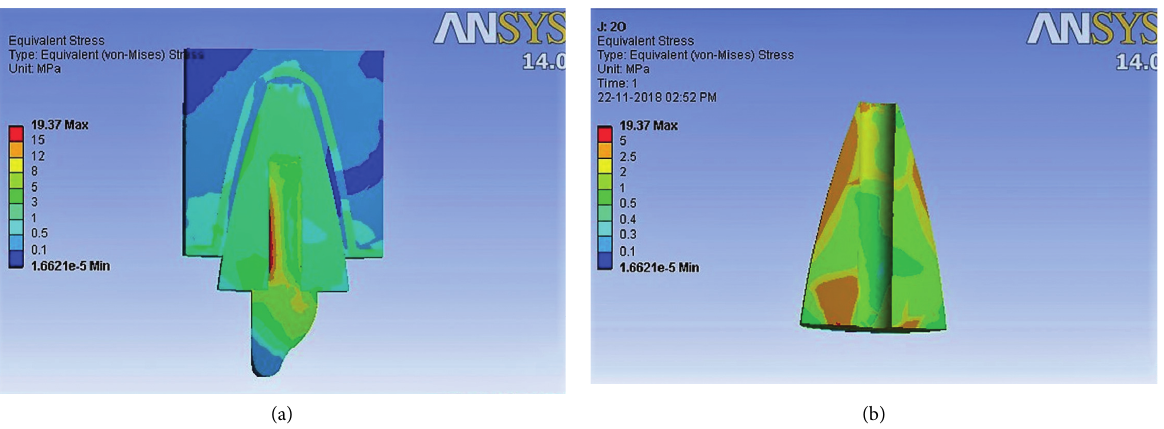
Figure 5: (a) Areas of stress concentration in Model 2 on oblique loading. (b) Areas of Stress concentration in Model 2 in root cross